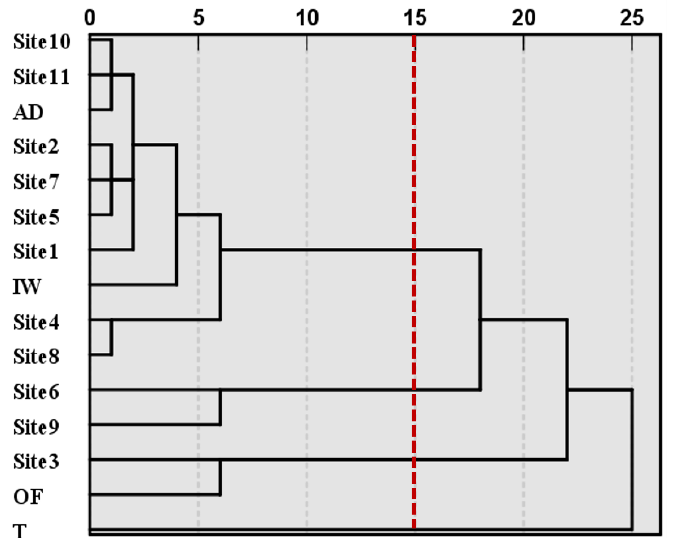
Figure 4. Dendrogram of the hierarchical clustering of the ratio of heavy metals accumulated at different sites. The pollution sources are atmospheric deposition (AD), irrigation water (IW), organic fertilizer (OF), and tailings (T).